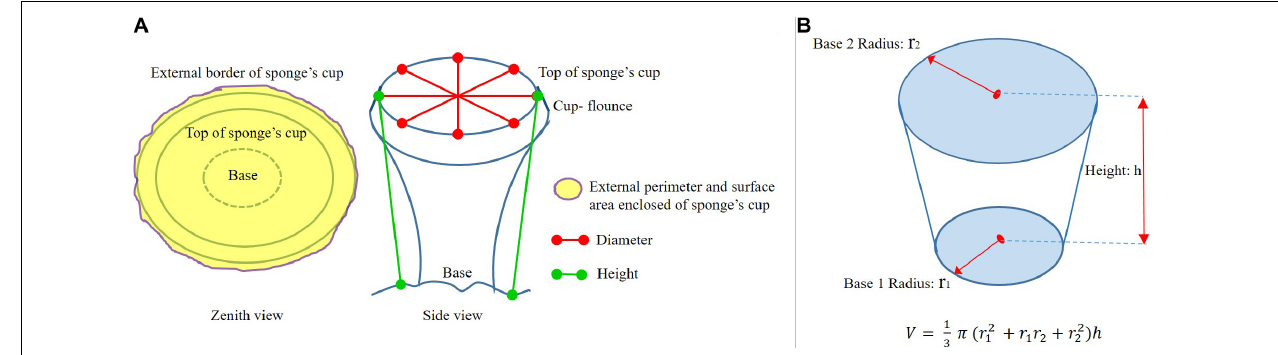
FIGURE 6 | (A) Diagram of the parameters measured to define the size of the A. setubalense specimens in this study. (B) Diagram of truncated cone geometric shape used for the calculation of volume of A. setubalense